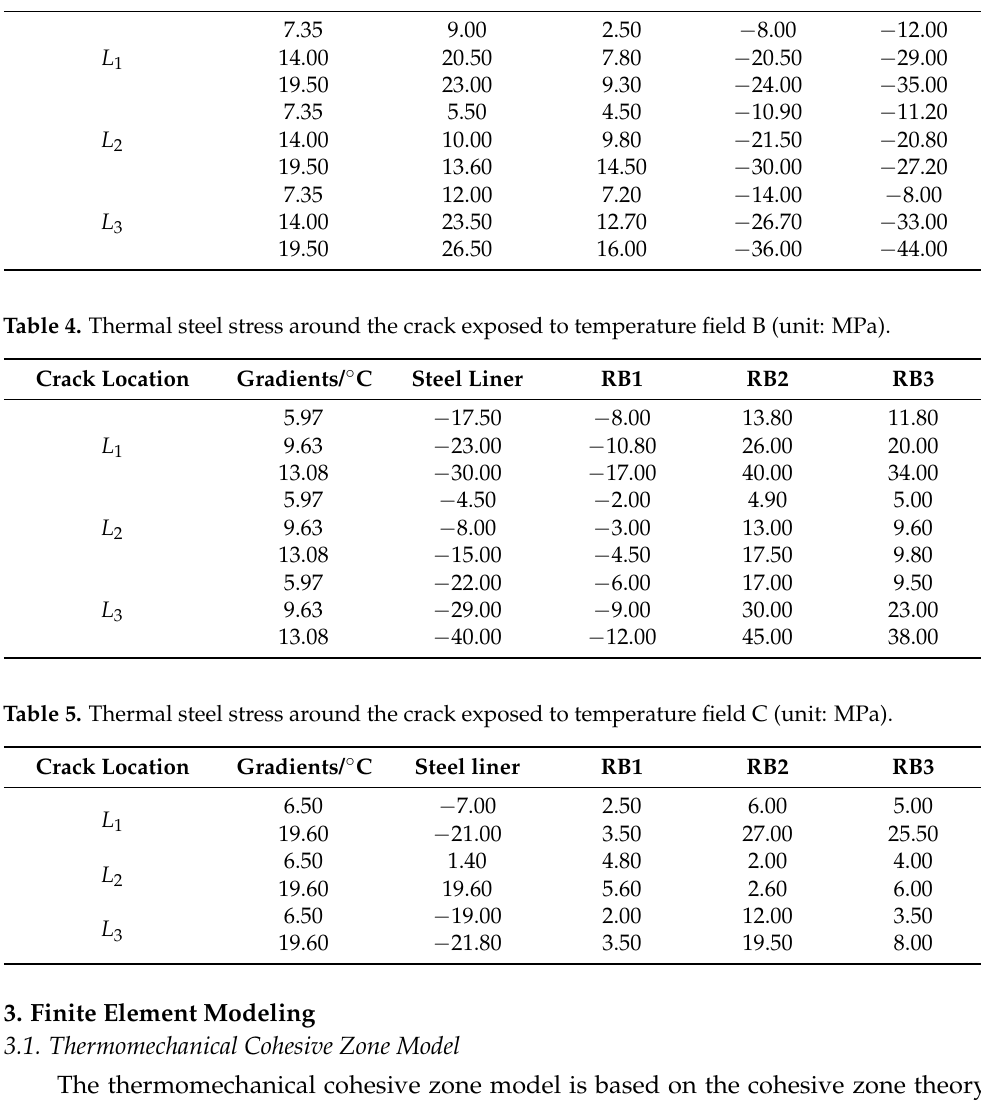
Table 3. Thermal steel stress around the crack exposed to temperature field A (unit: MPa). Crack Location